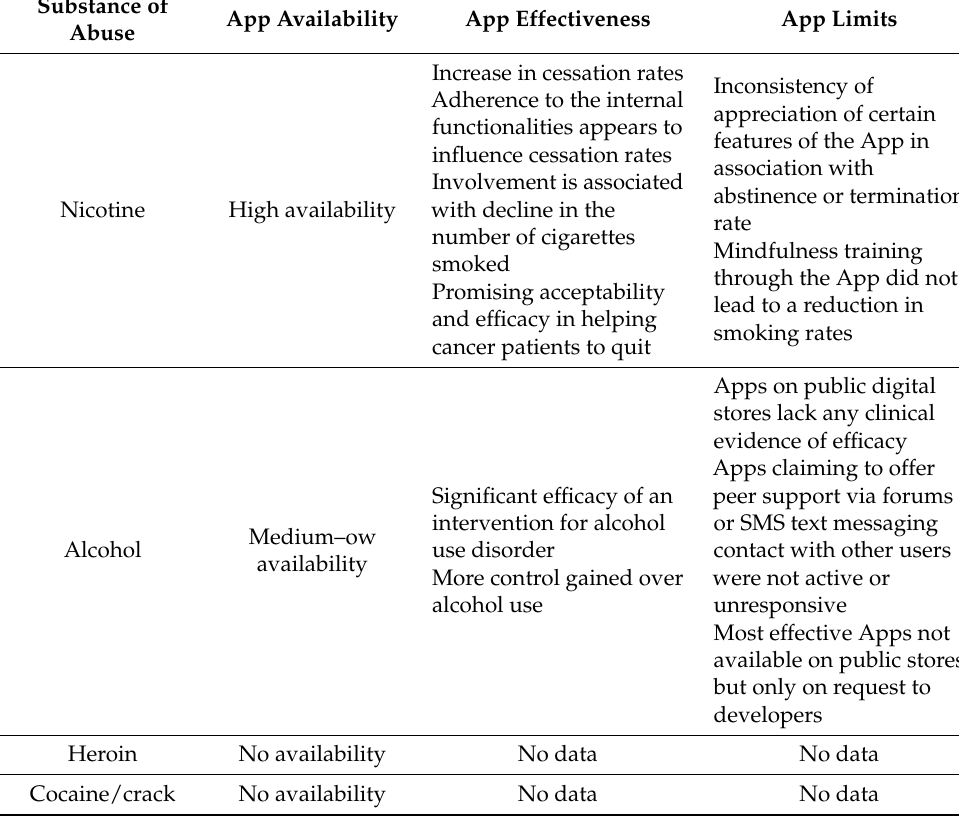
Table 3. Summary with the substances of abuse treated and the characteristics of the Apps analyzed. Substance of App Availability App Effectiveness App Limits Abuse Increase in cessation rates Adherence to the internal functionalities appears to influence cessation rates Involvement is associated Nicotine High availability with decline in the number of cigarettes smoked Promising acceptability and efficacy in helping cancer patients to quit